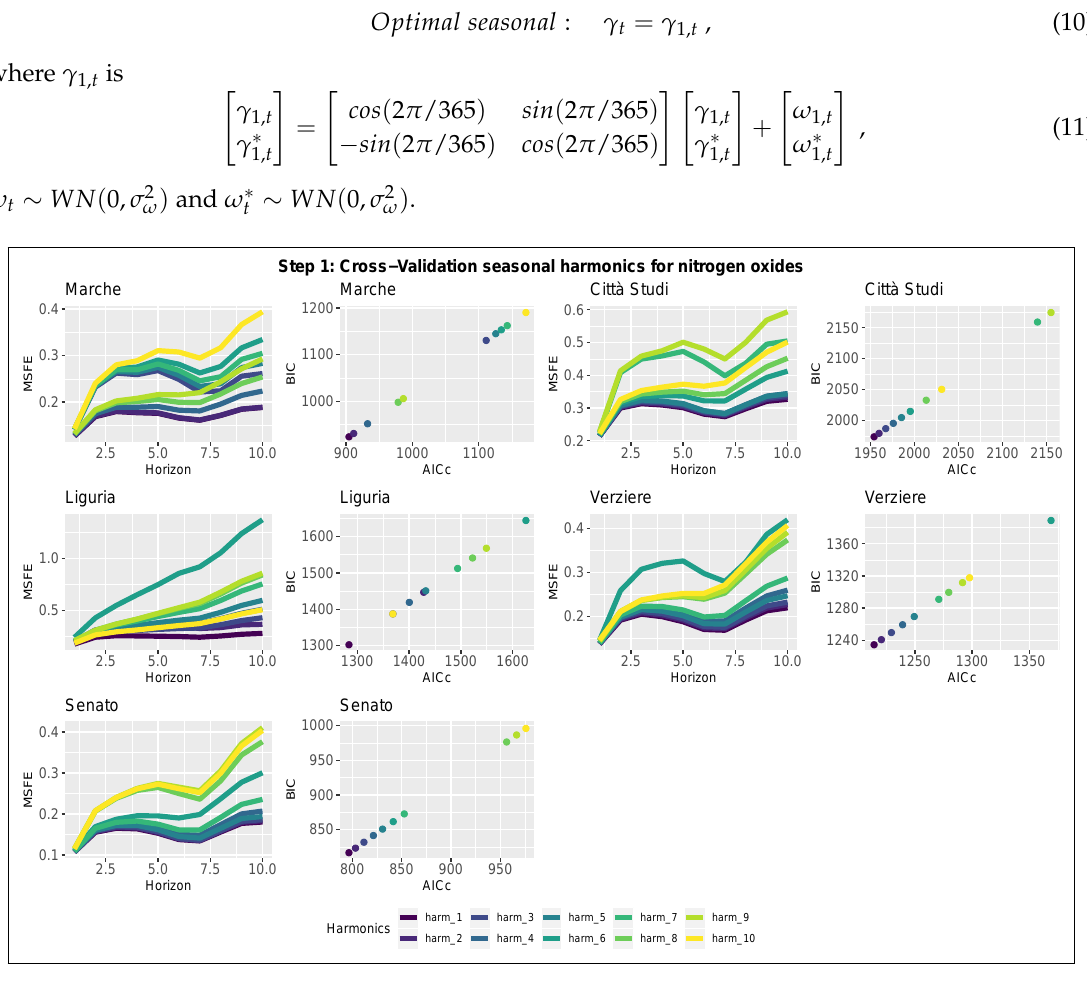
Figure 5. Model selection-Step 1-NO x . Seasonal component selection for the five nitrogen oxides stations in Milan. Left panel: 10-steps-ahead MSFE in log-scale as function of the number of harmonics. Right panel: AICc and BIC pairs for each